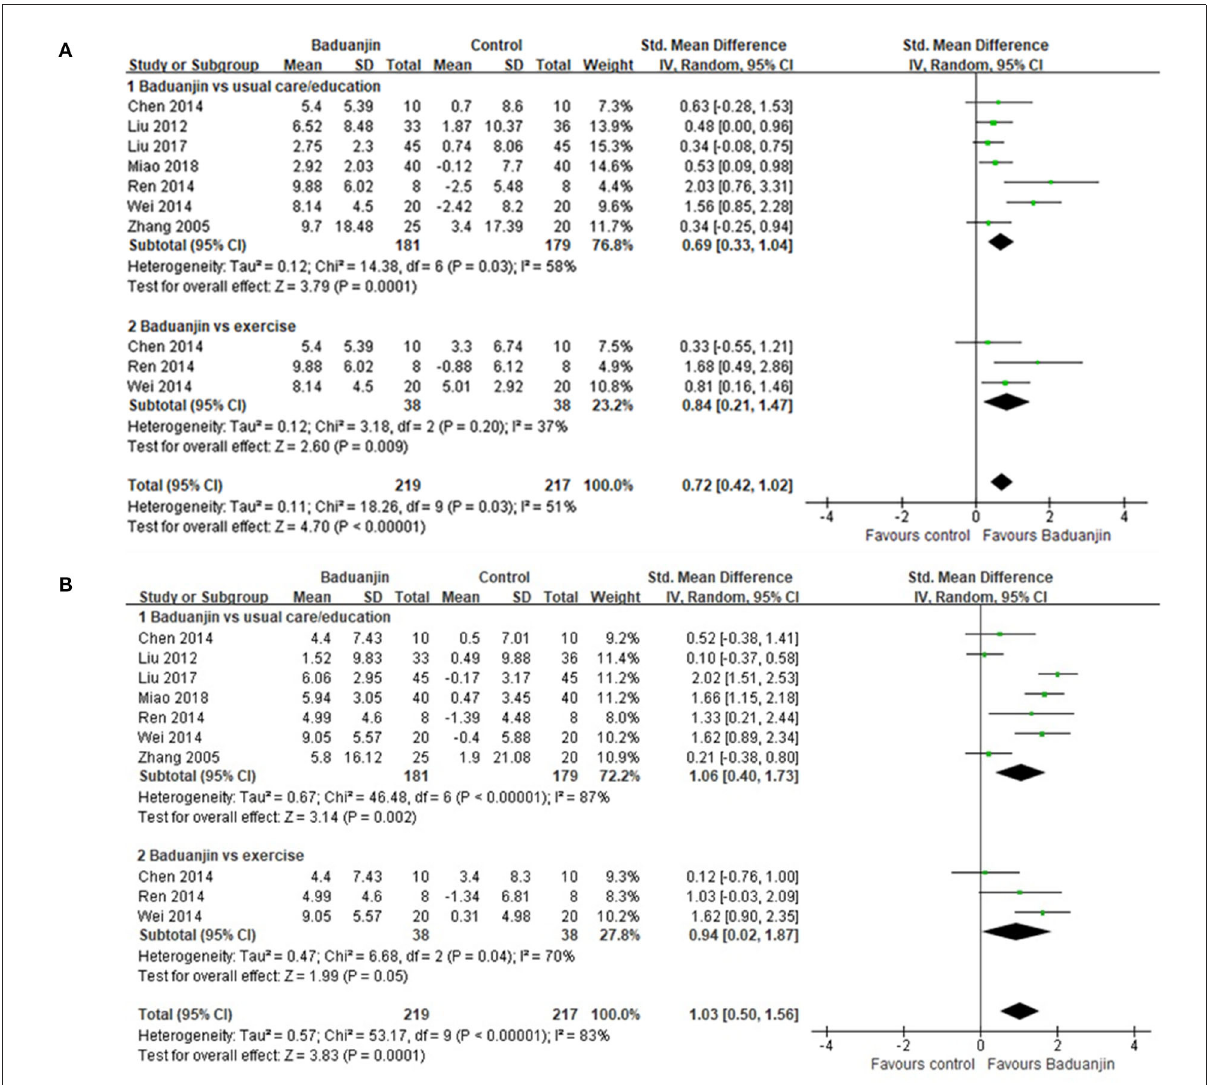
FIGURE3 Forest plot of the effects of Baduanjin exercises on quality of life. (A) mental component scores, (B) physical component